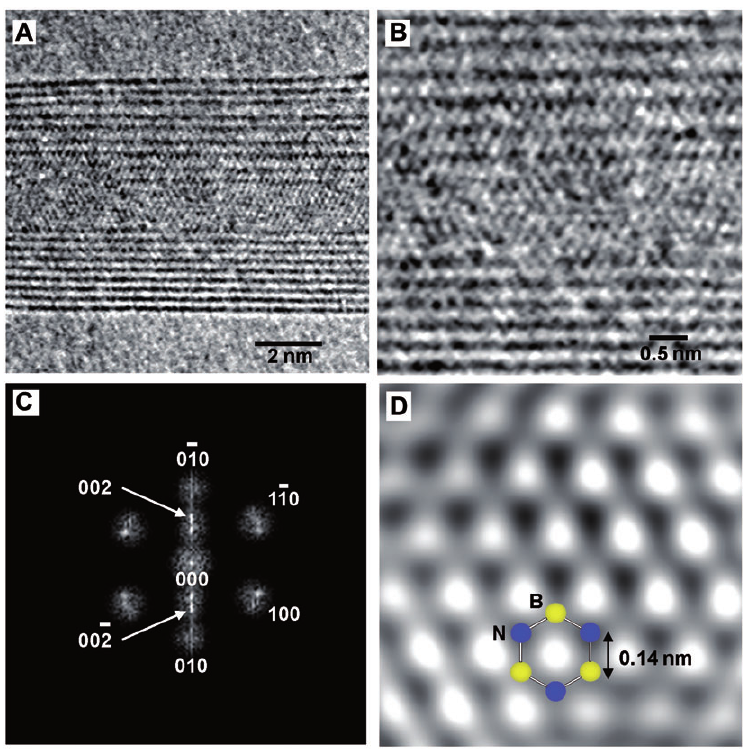
Figure 18 (A) HREM image of armchair-type BN nanotube. (B) Enlarged HREM image of (A). (C) Filtered Fourier transform of (B). (D) Inverse Fourier transform of